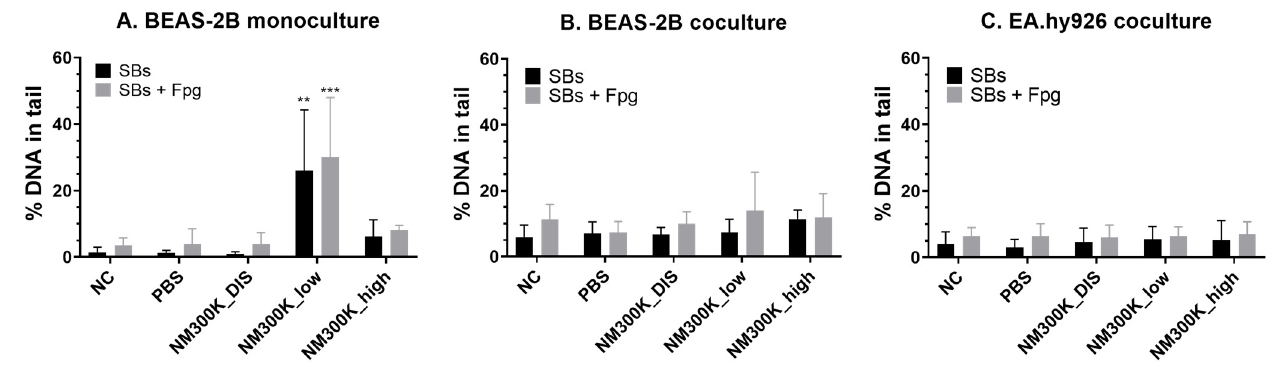
Figure 5. DNA damage by strand breaks (SBs) and oxidized base lesions (Fpg) of BEAS-2B and EA.hy926 cells after exposure to aerosolized NM-300K and control solutions at the air–liquid interface, evaluated by the comet assay. The response of cells in monocultures ( A ) was different compared with cocultures ( B , C ). Results are presented as the mean with standard deviation from single or duplicate inserts from n = 3–6 ( A ), n = 3 ( B ), and n = 4 ( C ) independent experiments. Statistically significant different effects on DNA damage compared to control inserts with PBS-exposed cells (PBS) were analyzed by one-way ANOVA followed by Dunnett ´ s post-hoc test (** p < 0.01, *** p < 0.001). NC: negative control, PBS: phosphate-buffered saline, NM-300K DIS: dispersant control, NM-300K low: nominal 1 µ g/cm 2 , NM-300K high: nominal 10 µ g/cm 2 .